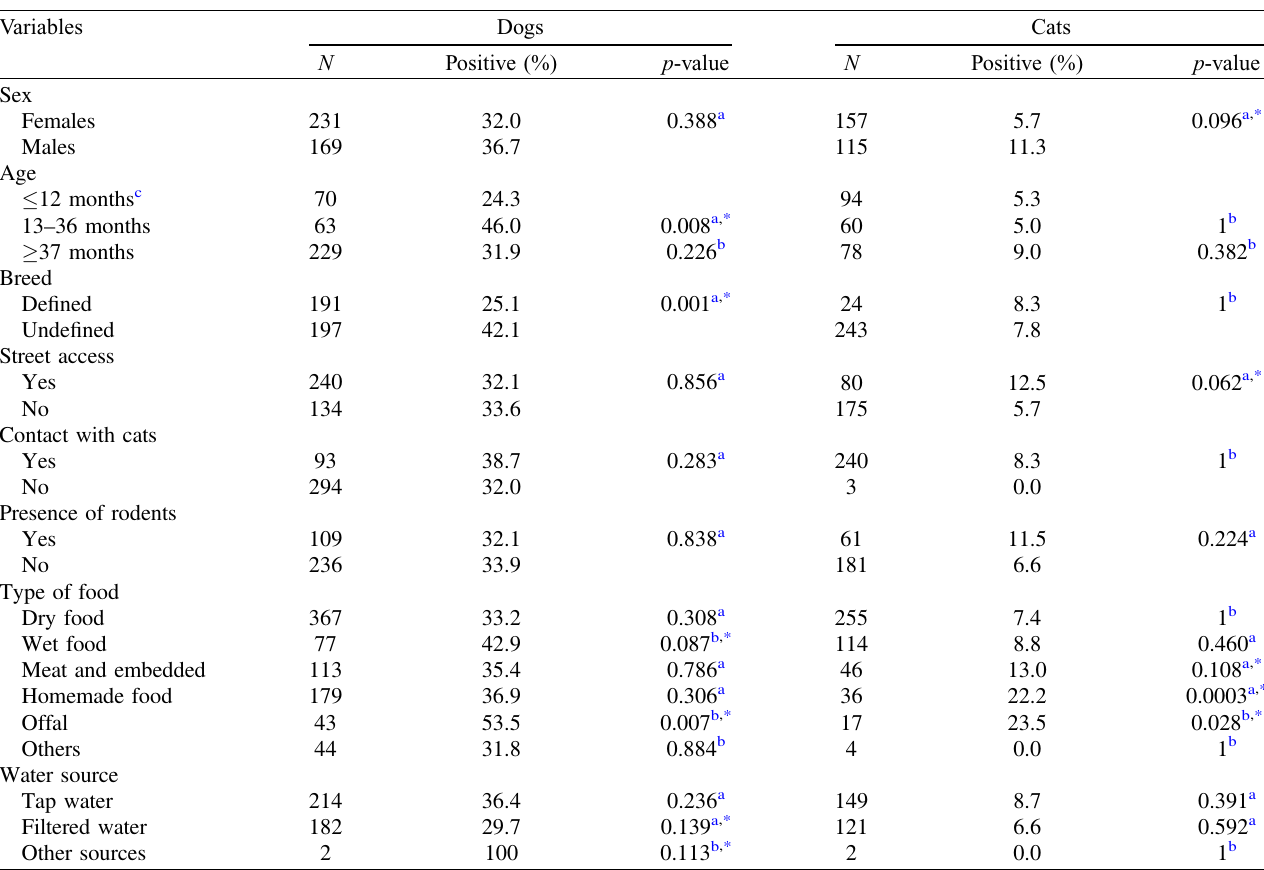
Table 2. Univariable analysis ( p (cid:3) 0.20) of the associated factors with T. gondii infection in domestic dogs and cats treated at Municipal Institute of Veterinary Medicine Jorge Vaitsman from August 2017 to January 2020.